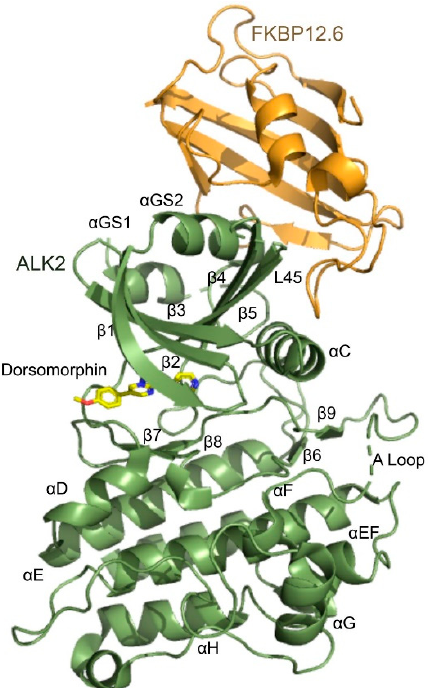
Figure 2. Structure of the ALK2-FKBP12.6 complex with dorsomorphin. ALK2 (green) and FKBP12.6 (orange) are shown in ribbon representation with secondary structural elements labelled. Regions missing in the electron density maps, where the chain could not be modeled, are shown by dashed lines. The kinase inhibitor dorsomorphin bound in the ATP-binding site is shown in a stick represen- tation with its carbon, oxygen, and nitrogen atoms displayed in yellow, red, and blue,